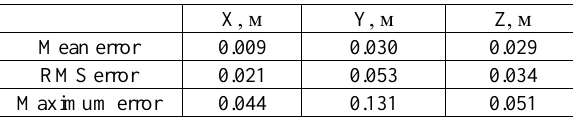
Table 4. Absolute accuracy estimation of MLS data adjustment using check points